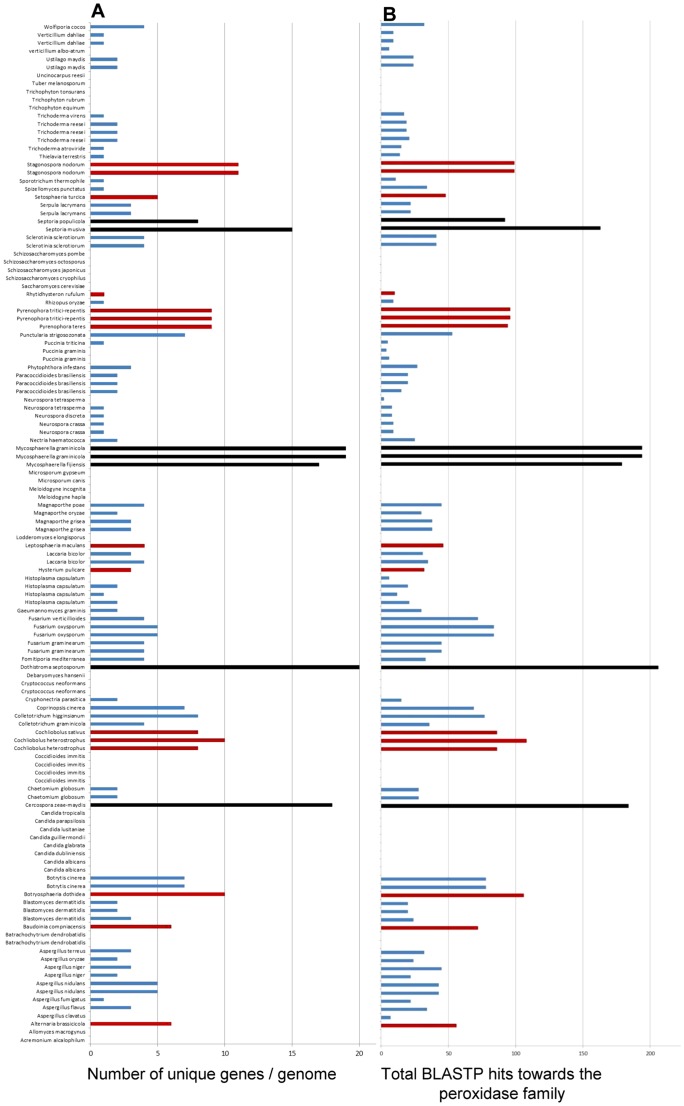
Interspecies genome BLASTP counts for homologues of the M. graminicola secreted protein family with peroxidase/chloroperoxidase activity (PFAM; PF01328).(A) The number of unique protein homologues of protein 90087, a representative member of the secreted peroxidase family. (B) Total number of BLASTP hits in each species towards the 11 predicted secreted peroxidases from M. graminicola. Black bars highlight Mycosphaerellaceae species; red bars highlight other Dothideomycetes. Analysis performed at a BLASTP cut-off of e-5.